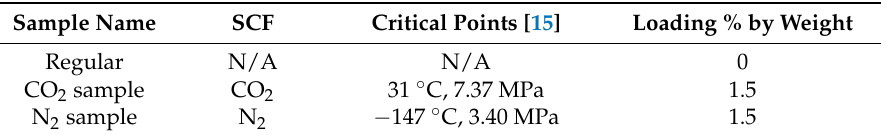
Table 1. Sample name and SCF loading percent.